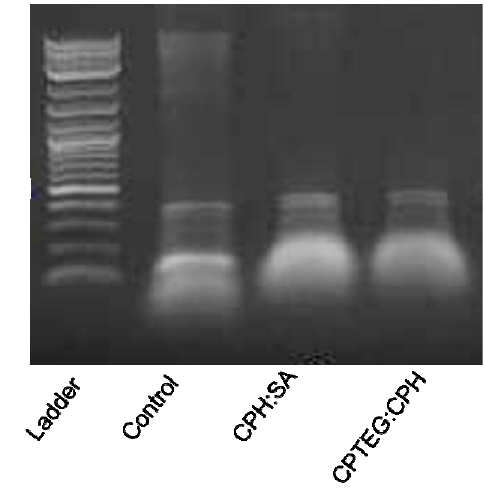
Figure 2. Stability of released dsRNA from nanoparticles. Released dsRNA from nanoparticles was evaluated for using gel electrophoresis.